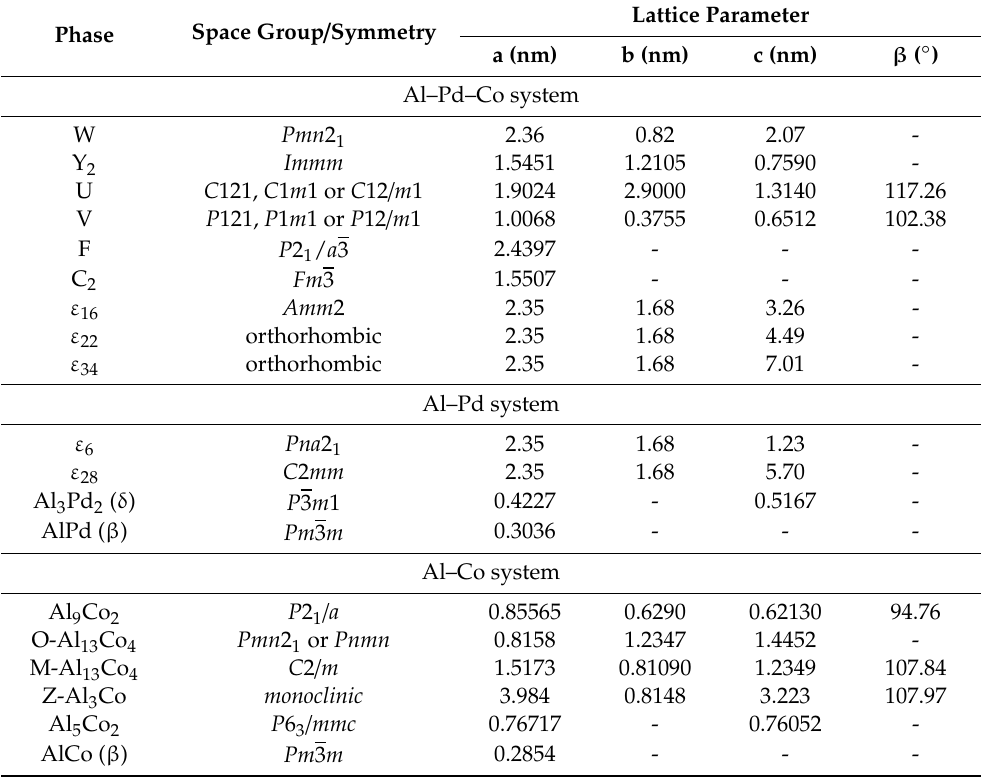
Table 1. Overview of selected binary and ternary phases occurring in the Al–Pd–Co system and related binaries